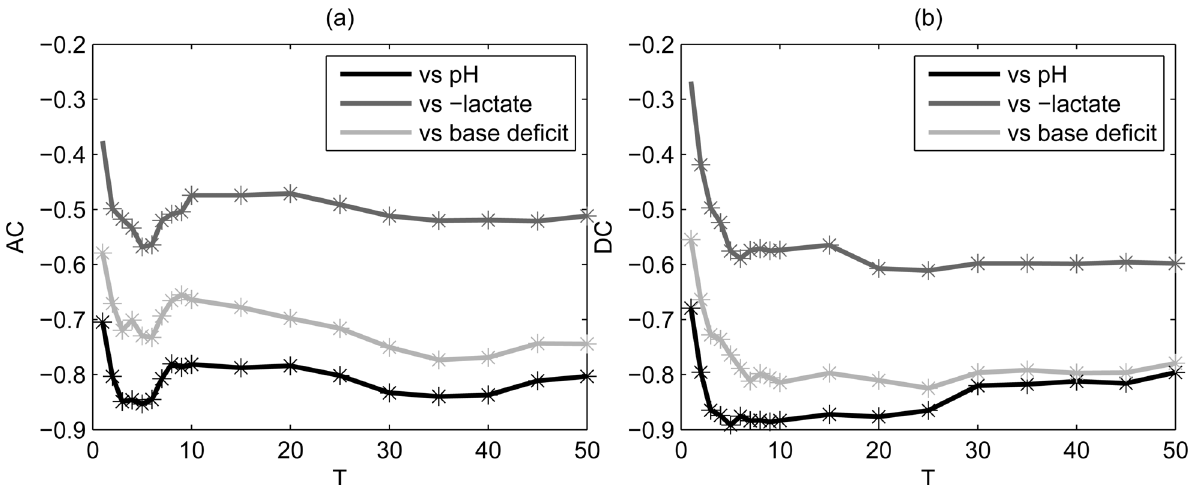
Figure 5. Spearman’s correlation coefficients between AC (a) and DC (b) and each acid-base balance biomarker. PRSA was performed on the entire fRR series. Stars refer to significant p values (p , 0.05). Lactate values were multiplied by 2 1.